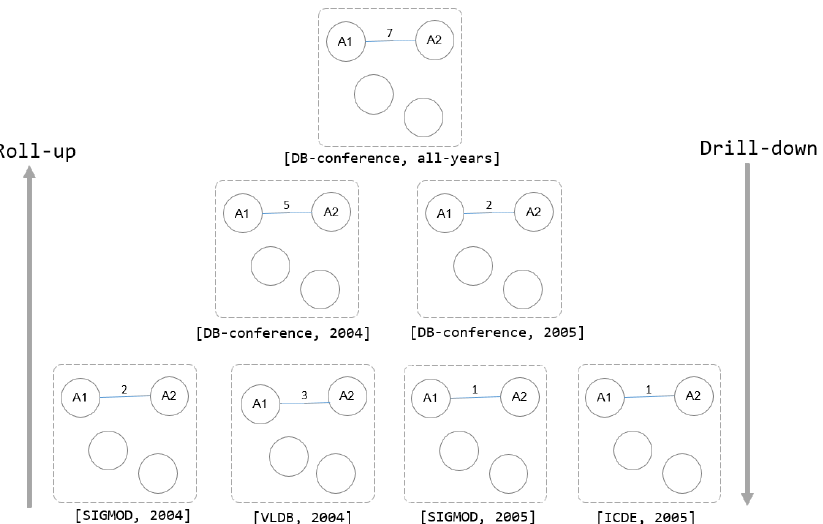
Figure 11. Operation, Roll-up, and Drill-down for informational on-line analytical analysis (I-OLAP).